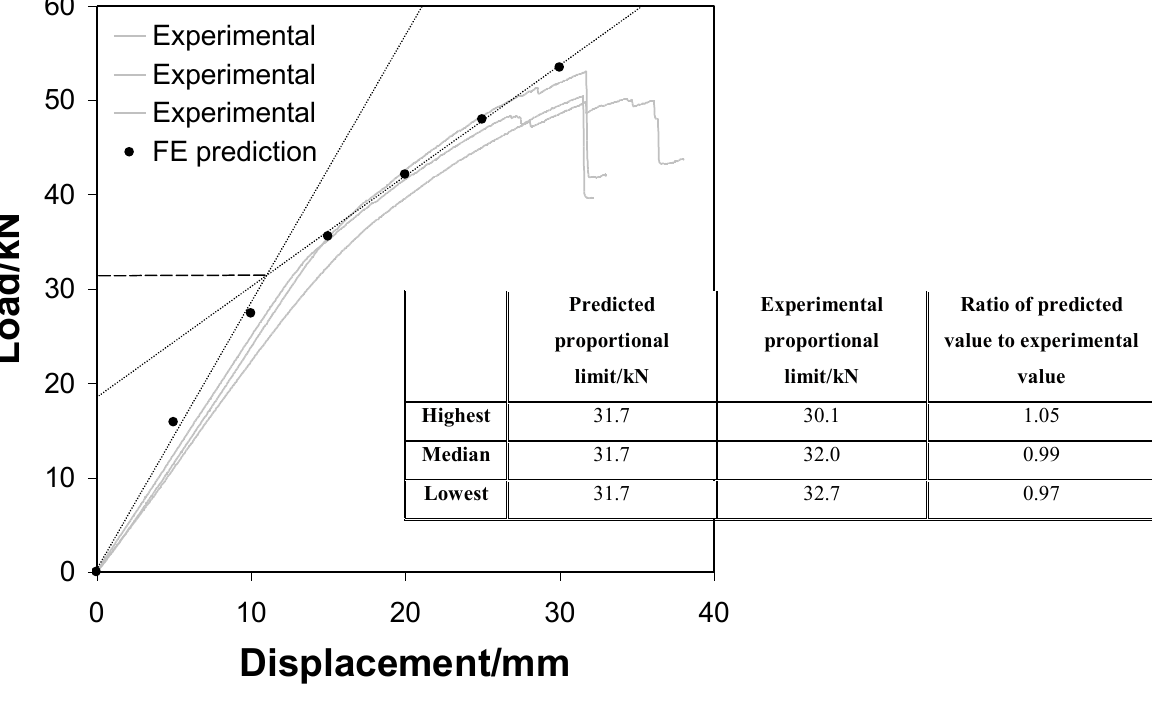
Figure 11. Load-displacement curves for series IV tested steel-reinforced LVL samples (in grey) and estimated finite element predictions (black dots). A comparison is made between the predicted and experimental proportional